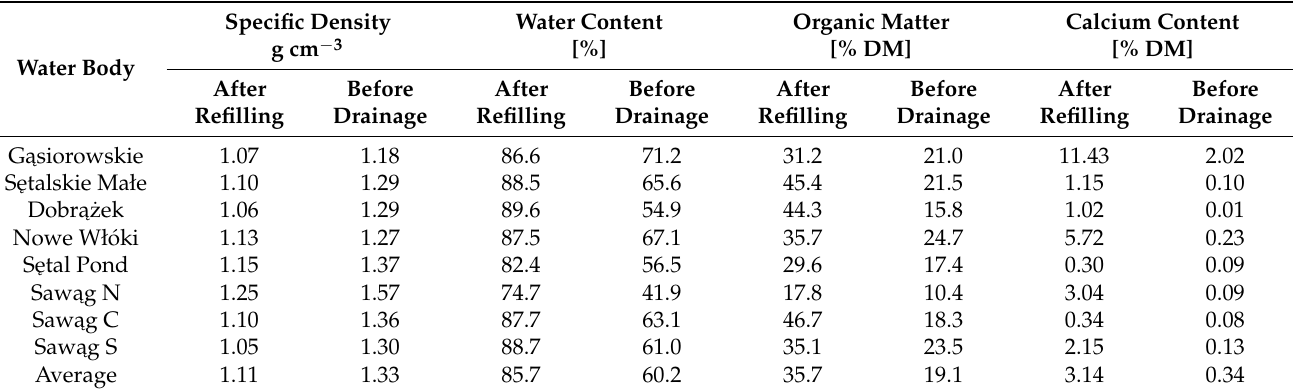
Table 4. Parameters of bottom sediments in the analysed water bodies, calculated as mean values for two vertical zones of sediment cores: ‘After refilling’ means the part of sediment deposited after restoration and ‘Before drainage’ refers to the lower part of sediment, which was influenced by the dry conditions prevailing during the drying period in each water